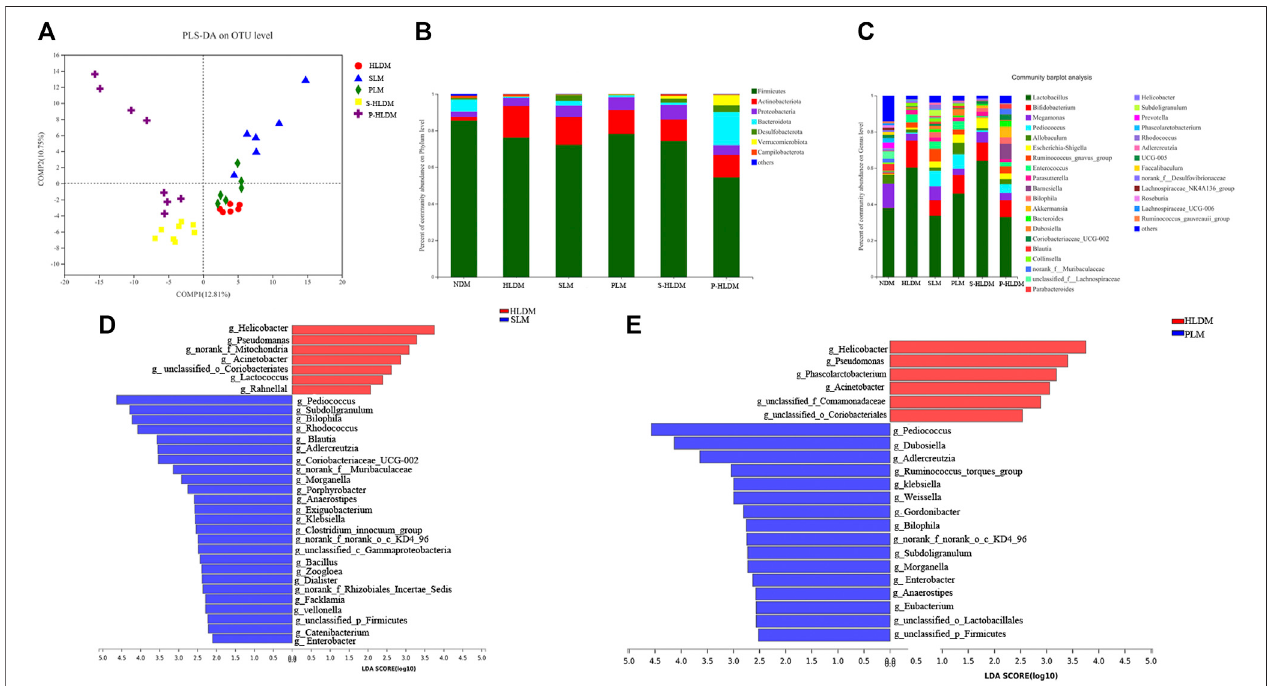
FIGURE5| Effectsofdifferenttreatmentsonmucosalbacterialcommunitystructure (A) PLS-DAscoreplotsbasedontherelativeabundancesofmicrobialgenera of different groups. Relative abundance of mucosal bacteria at the phylum level (B) and genus level (C) among distinct groups. Linear discriminant analysis effect size (LEfSe) analysis of the mucosal microbiota differences between HLD& SL (D) and HLD& PL (E) at the genus level.